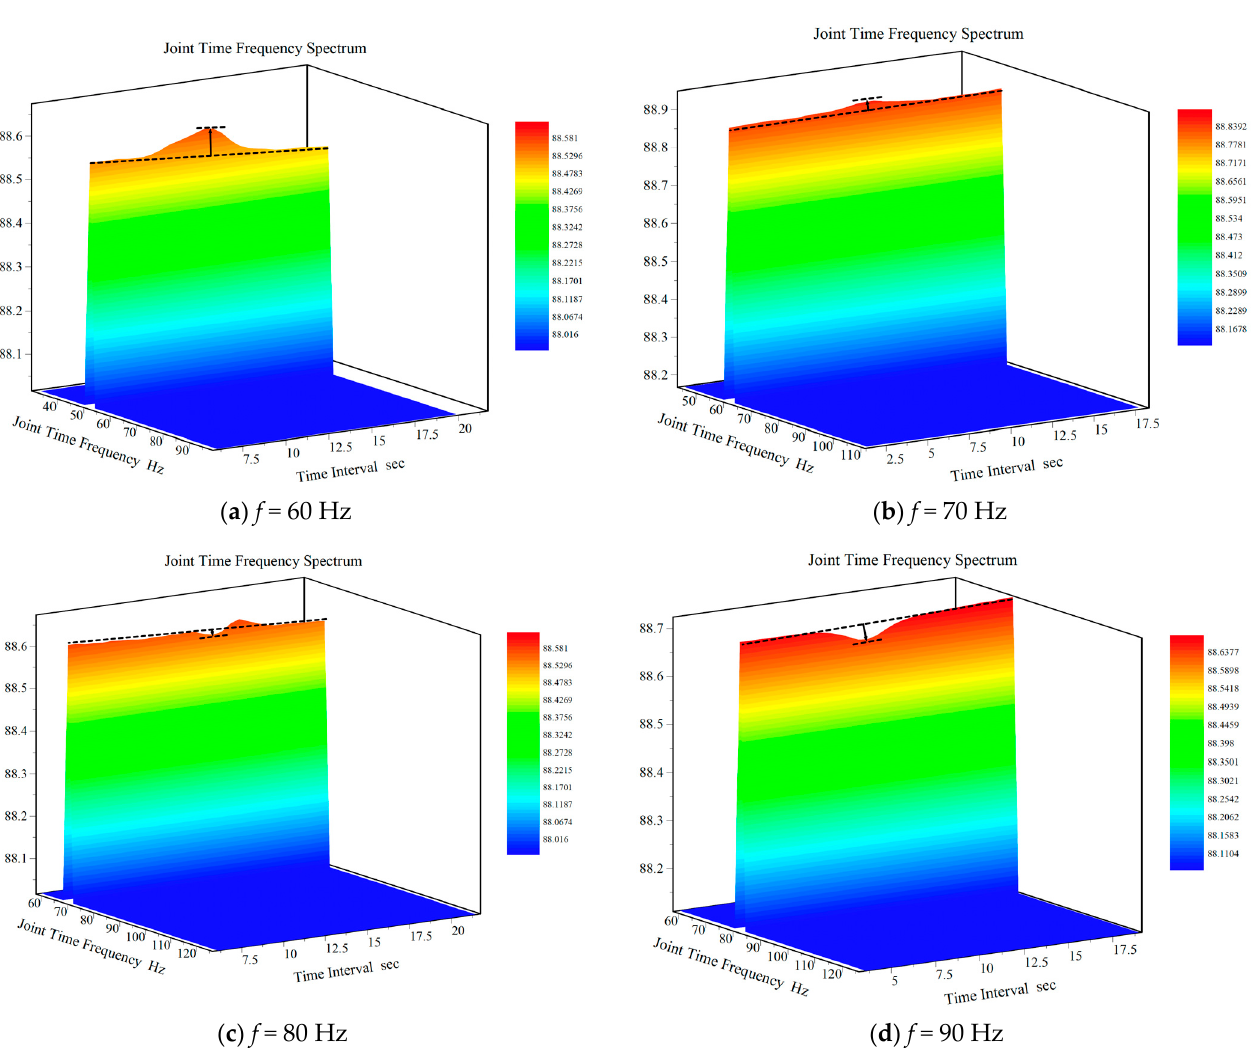
Figure 9. The JTFS of the first orientation of the copper cone detected by sinusoidal excitation signals of different frequencies.